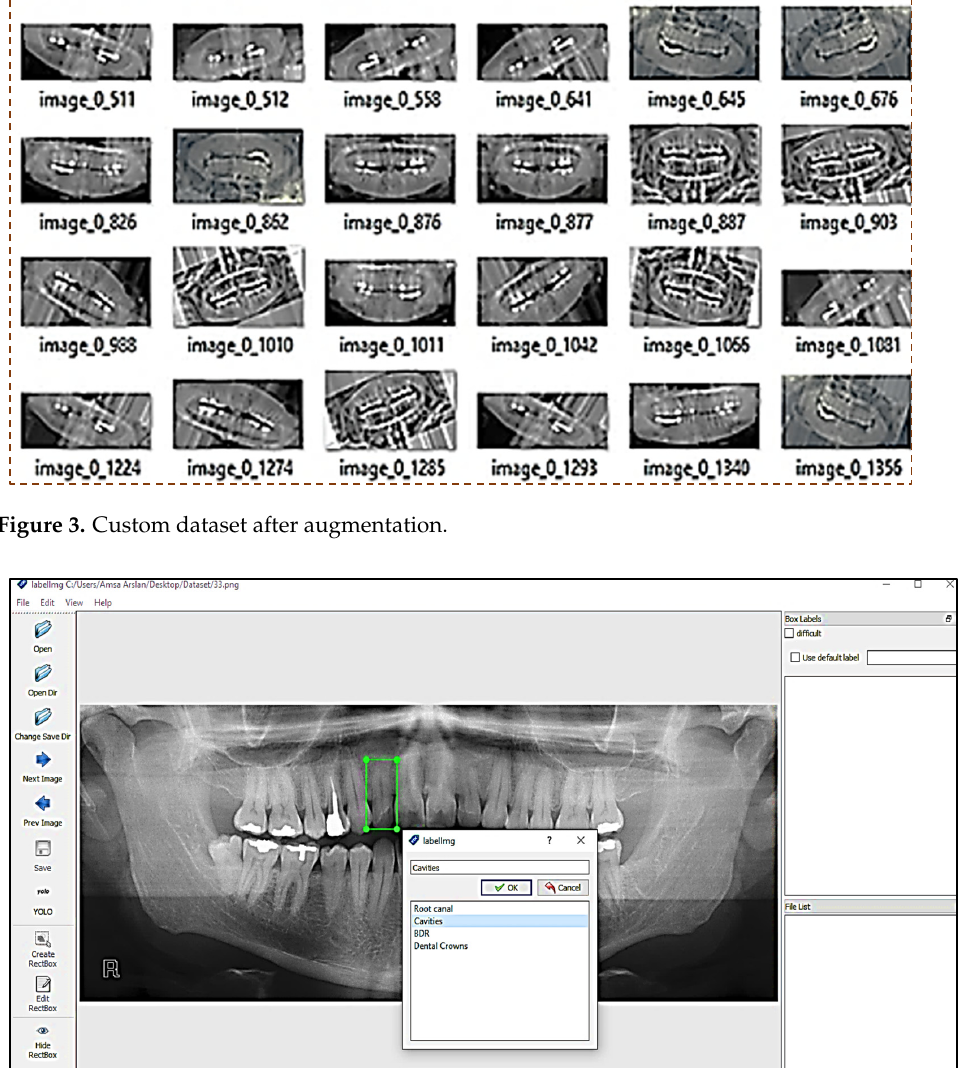
Figure 5. Annotation file in .txt format. 4.4. Yolo (You Only Look Once) J. Redmon et al. were the first to use YOLO in 2015. YOLOv1, YOLOv2, and YOLOv3 are three types of object detectors and classifiers. YOLOv1 has a problem with localisation and recall values that are not as good as the other models. YOLOv2 is entirely based on the CPU and requires more time to train. YOLOv3 was implemented in May 2018 [31]. It is a cutting ‐ edge detector that produces better results in terms of speed and accuracy and is intended for GPU use. We used YOLOv3, by implementing its dark net framework, because of its performance and better results. YOLOv3 ′ s detection procedure differs from that of other models. It only takes an image and sends it to the network once for further processing. The image is divided into S × S grid cells. Every grid cell’s responsibility is to predict the object centred in that grid cell and its bounding boxes, using their confidence scores. Confidence scores look at how likely objects are to exist and how confident they are in their prediction. In each grid cell, the conditional class probabilities should be observed. It is made up of 24 Conv layers and two fully connected layers. Some layers assemble the initial module, beginning with 1 × 1 reduction layers and progressing to 3 × 3 convolutional layers [32]. We used the dark net framework to put YOLO together. There are 53 network layers in the dark net. The residual block is a new type of block used by Darknet ‐ 53. Deep neural networks are difficult to train. As the network’s depth increases,